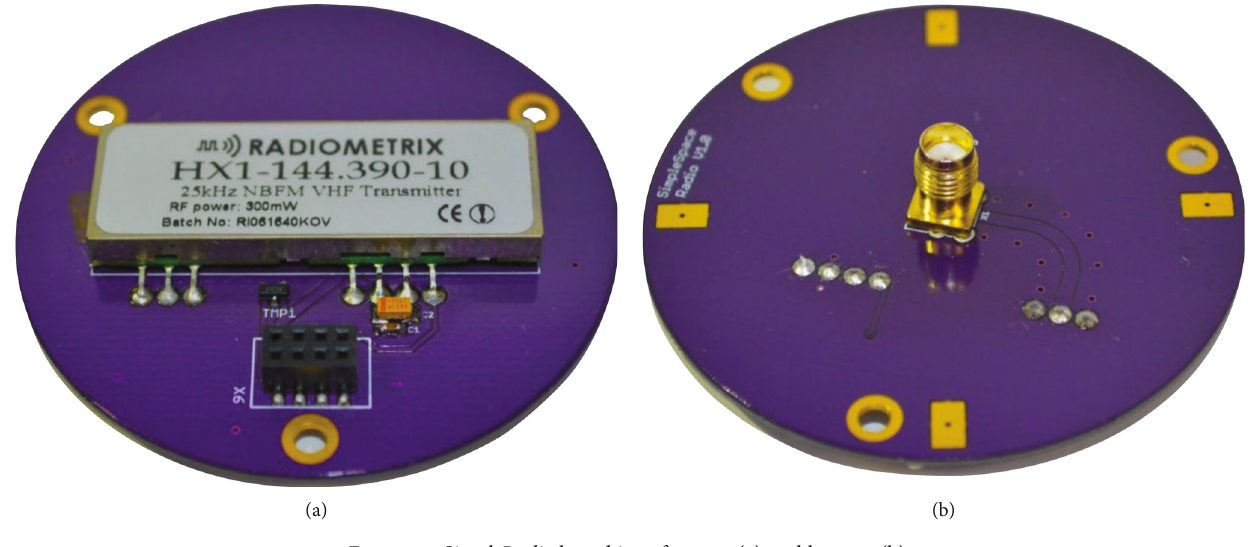
Figure 5: SimpleRadio board interface top (a) and bottom